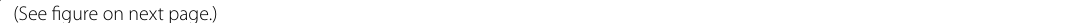
figure on next Fig. 4 Inhibition of FDPS decreased the autophagy level in vivo and in vitro PAH module. A Immunoblot analysis for LC3b, Beclin1 and P62 in the control, MCT-induced PAH rats and IB treated PAH rats. GAPDH was used as internal reference. n the MCTP induced autophagy in PAECs. PAECs transfected with Ad-mRFP-GFP-LC3 was observed and analyzed by microscopy. The representative images are displayed at left. Scale bars 20 μm. The numbers of green (GFP signal) and red (mRFP signal) puncta per cell were counted. n = per group. C Immunoblot analysis for P62 in the control, MCTP treated PAECs and IB treated PAECs. GAPDH was used as internal reference. n group. D Knockdown FDPS decreased the MCTP induced autophagy in PAECs. The representative images are displayed at left. Scale bars The numbers of green (GFP signal) and red (mRFP signal) puncta per cell were counted. n scramble, MCTP treated scramble PAECs and IB treated siFDPS transfected PAECs. GAPDH was used as internal reference. n expressed as the mean SEM. All experiments were independently replicated in triplicate. *p < ±